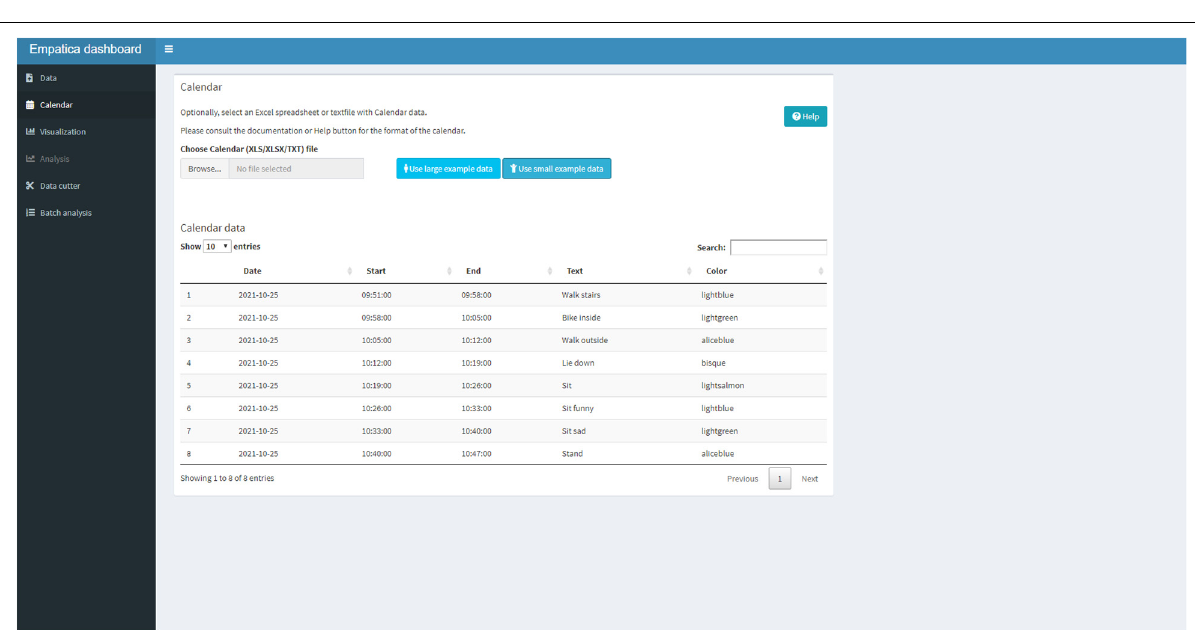
the HTML file are quite limited and intended for